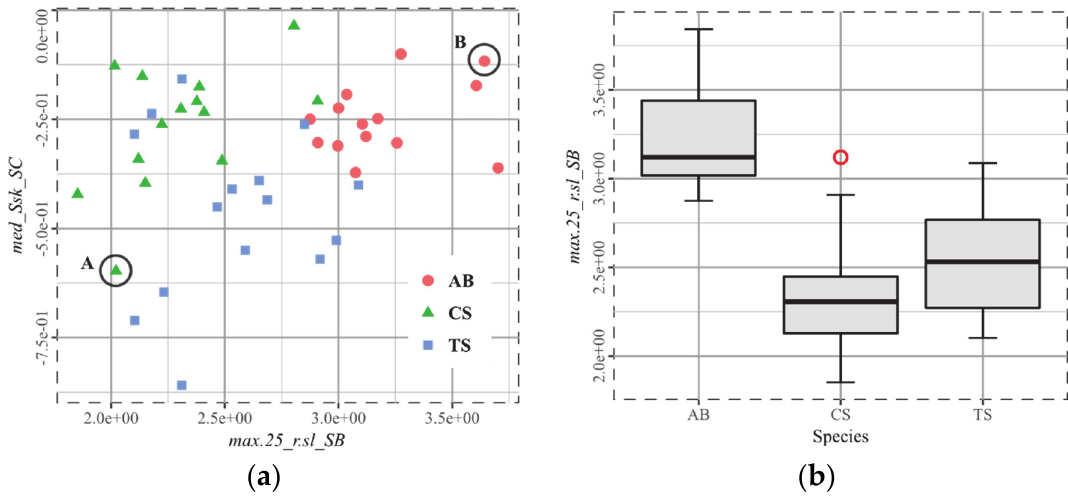
Figure 5 . African Ruminants, most discriminating parameters. ( a ) The anisotropy parameter r.sl clearly separates Alcelaphus buselaphus (AB) from the other groups. The surfaces related to the points (A) and (B) are represented in the ESM; and, ( b ) r.sl proves to be a grazer marker.